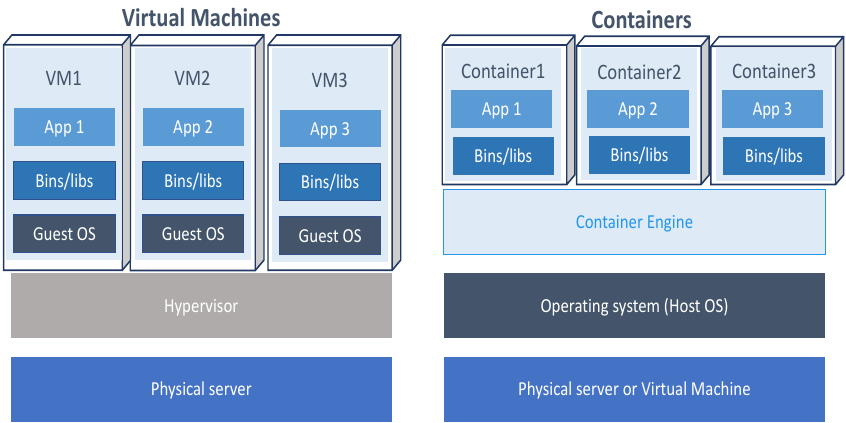
Figure 4. Generic Virtualization Architecture based on